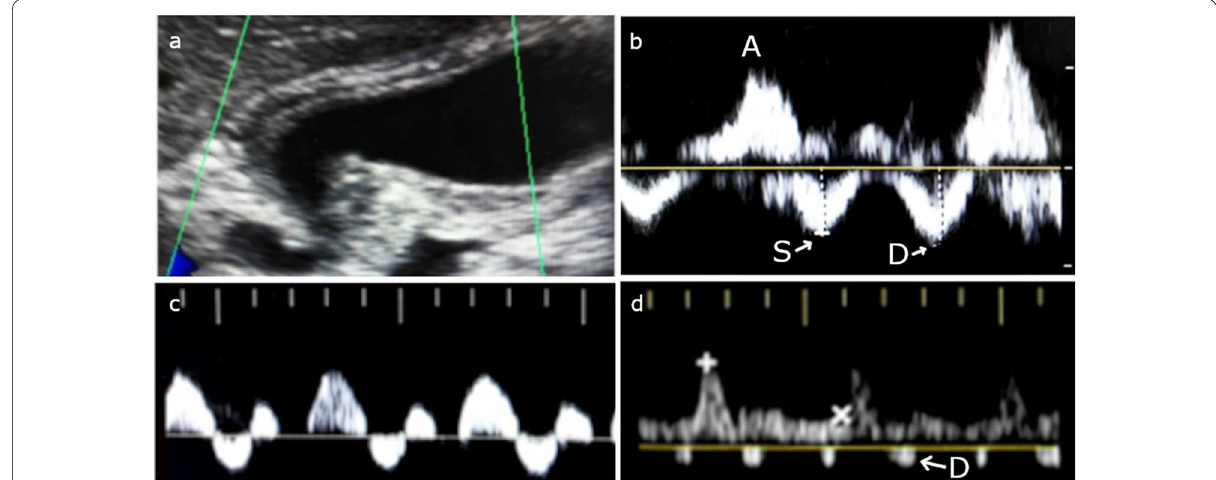
Fig. 3 Case 2: a gallbladder showing signs of acalculous cholecystitis. b Hepatic vein Doppler with high amplitude A waves with S < D forward flow waves. c Triphasic portal vein Doppler d biphasic interrupted intrarenal venous